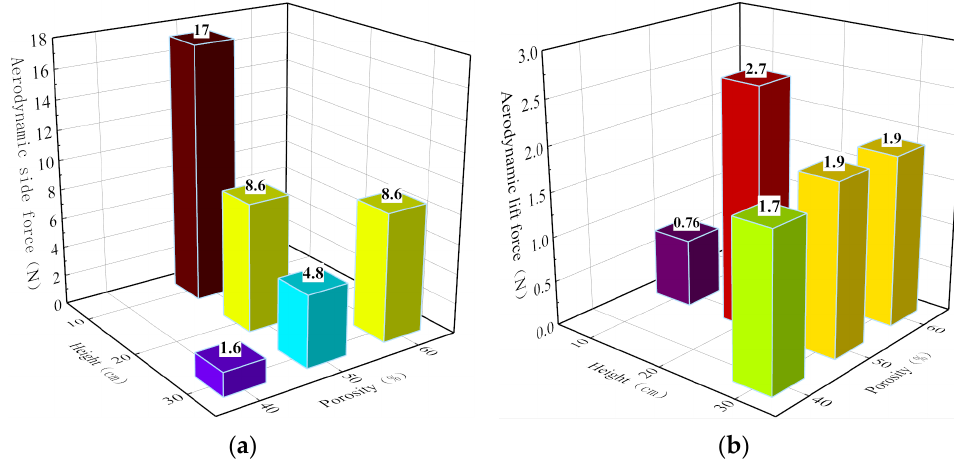
Figure 16. Effect of wind barrier on aerodynamic force (( a ) Side forces; ( b ) Lift forces).